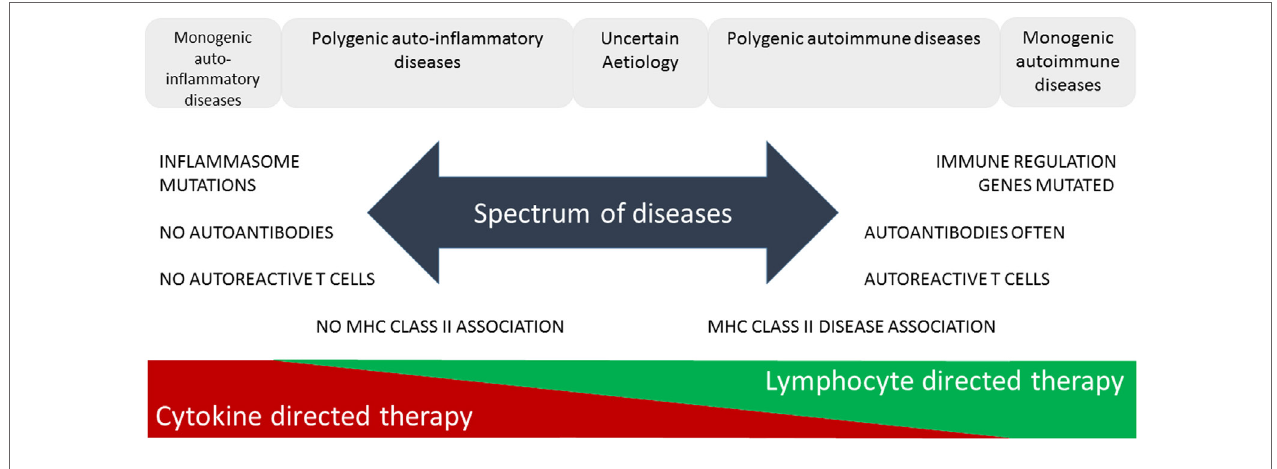
FiGUre 1 | Immune-mediated inflammatory diseases. This figure is based on “A proposed classification of the immunological diseases” by McGonagle and McDermott (5). The figure distinguishes the etiological basis of auto-inflammatory and autoimmune diseases and more clearly defines the definition of these diseases according to their monogenic or polygenic basis. The spectrum of diseases proposed are more associated with either innate (auto-inflammatory) or adaptive (autoimmune) immune responses and range from monogenic auto-inflammatory to monogenic autoimmune diseases. This classification not only helps us understand the genetic and immunological basis of the disease but also predicts more effective means of immunotherapy.